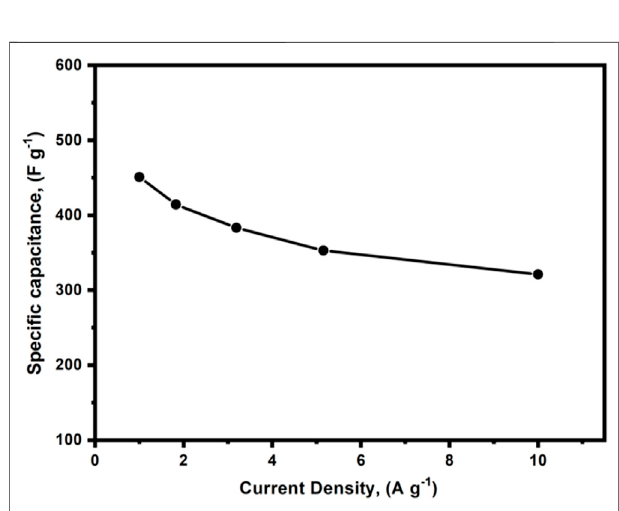
FIGURE 13 | Speci fi c capacitance pro fi les of c-4CzPN – KOH recorded at different current densities.